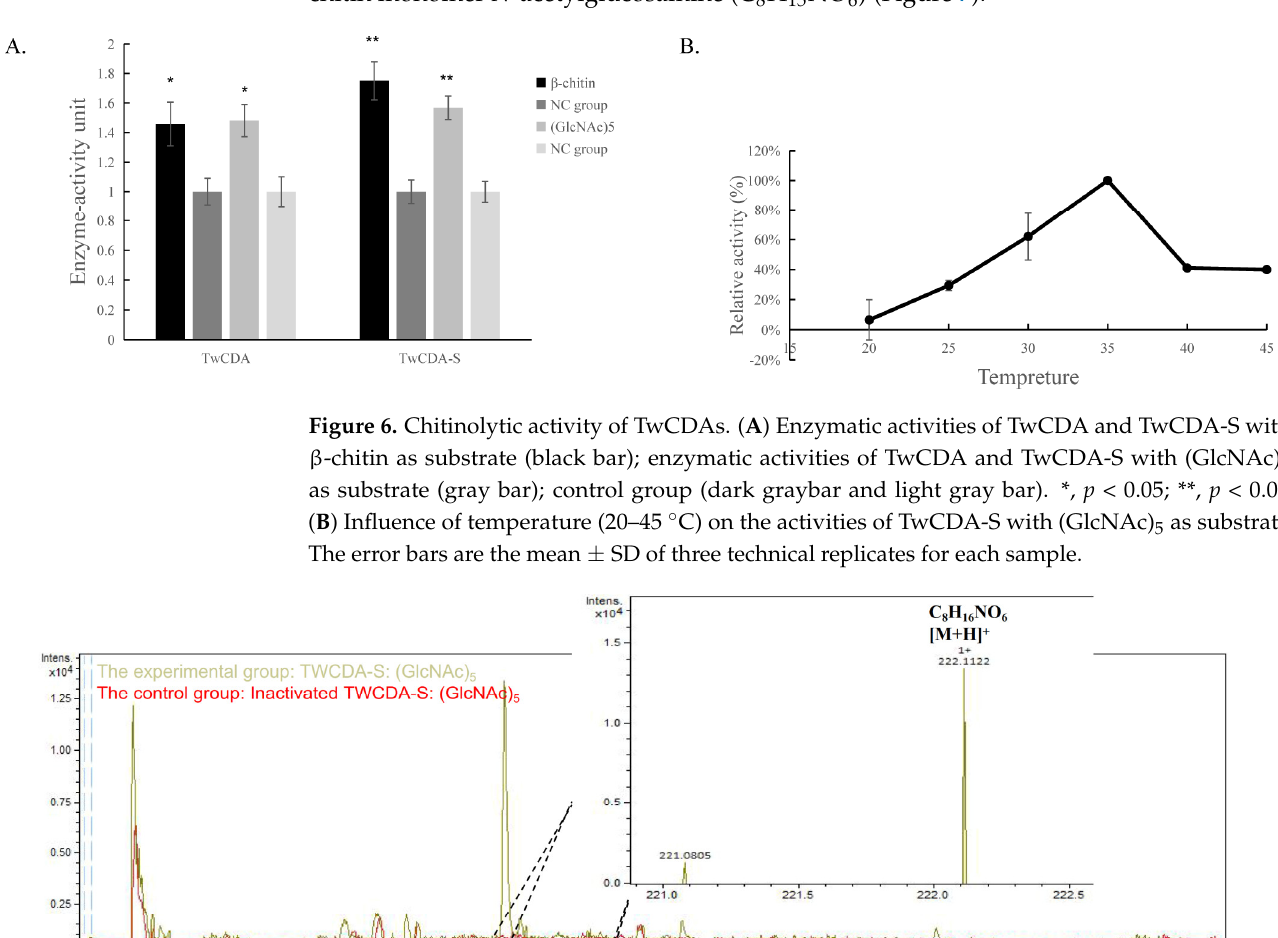
Figure 7. LC-coTOF-MS chromatograms. TwCDA-S and (GlcNAc) 5 were taken as the experimental group (green curves), and inactivated TwCDA-S (above panel) and (GlcNAc) 5 aqueous solution (below panel) were taken as the control group, respectively. The characteristic peak appeared at around 11 min in the experimental group, with the predicted molecular weight of 222.1122, which is in line with the MW of chitin monomer N -acetylglucosamine. Note the molecular ion species formed: [M + H] + .